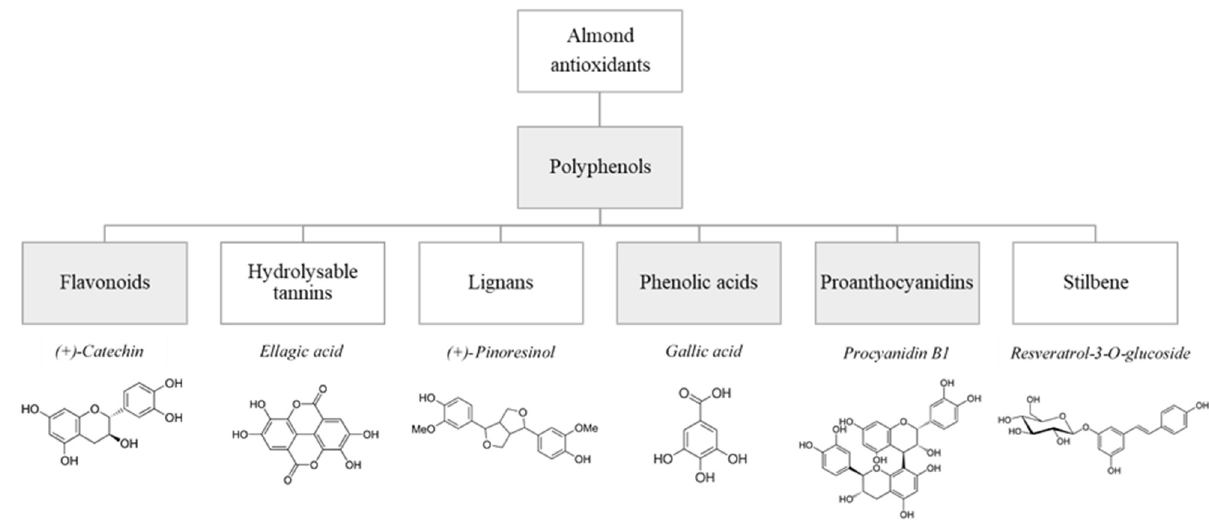
Figure 1. Examples of antioxidants present in almonds.